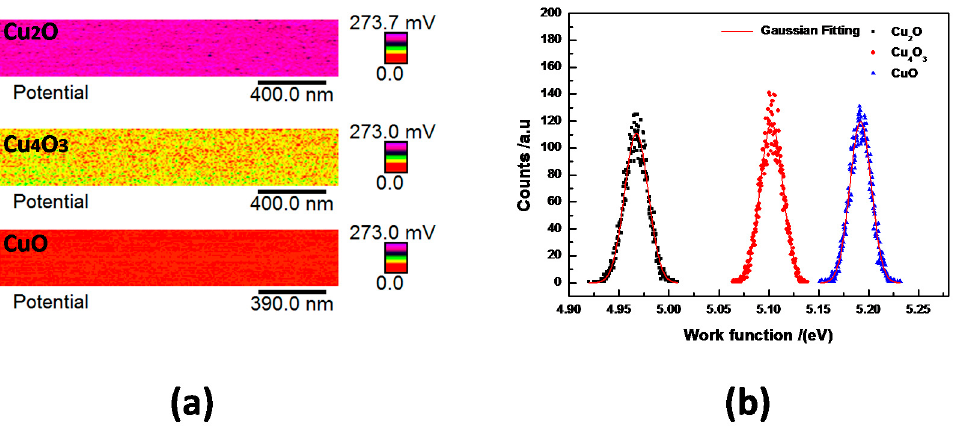
Figure 6. The V CPD ( a ) and work function distribution ( b ) on the surface of Cu 2 O, Cu 4 O 3 , and CuO thin films.